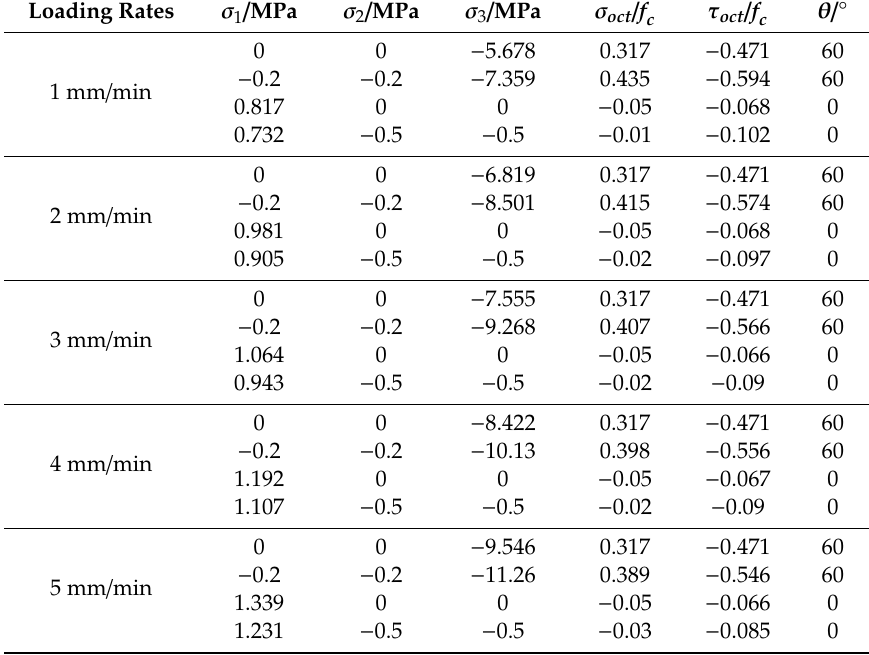
Table 10. Test results of asphalt mixture under di ff erent loading rates.